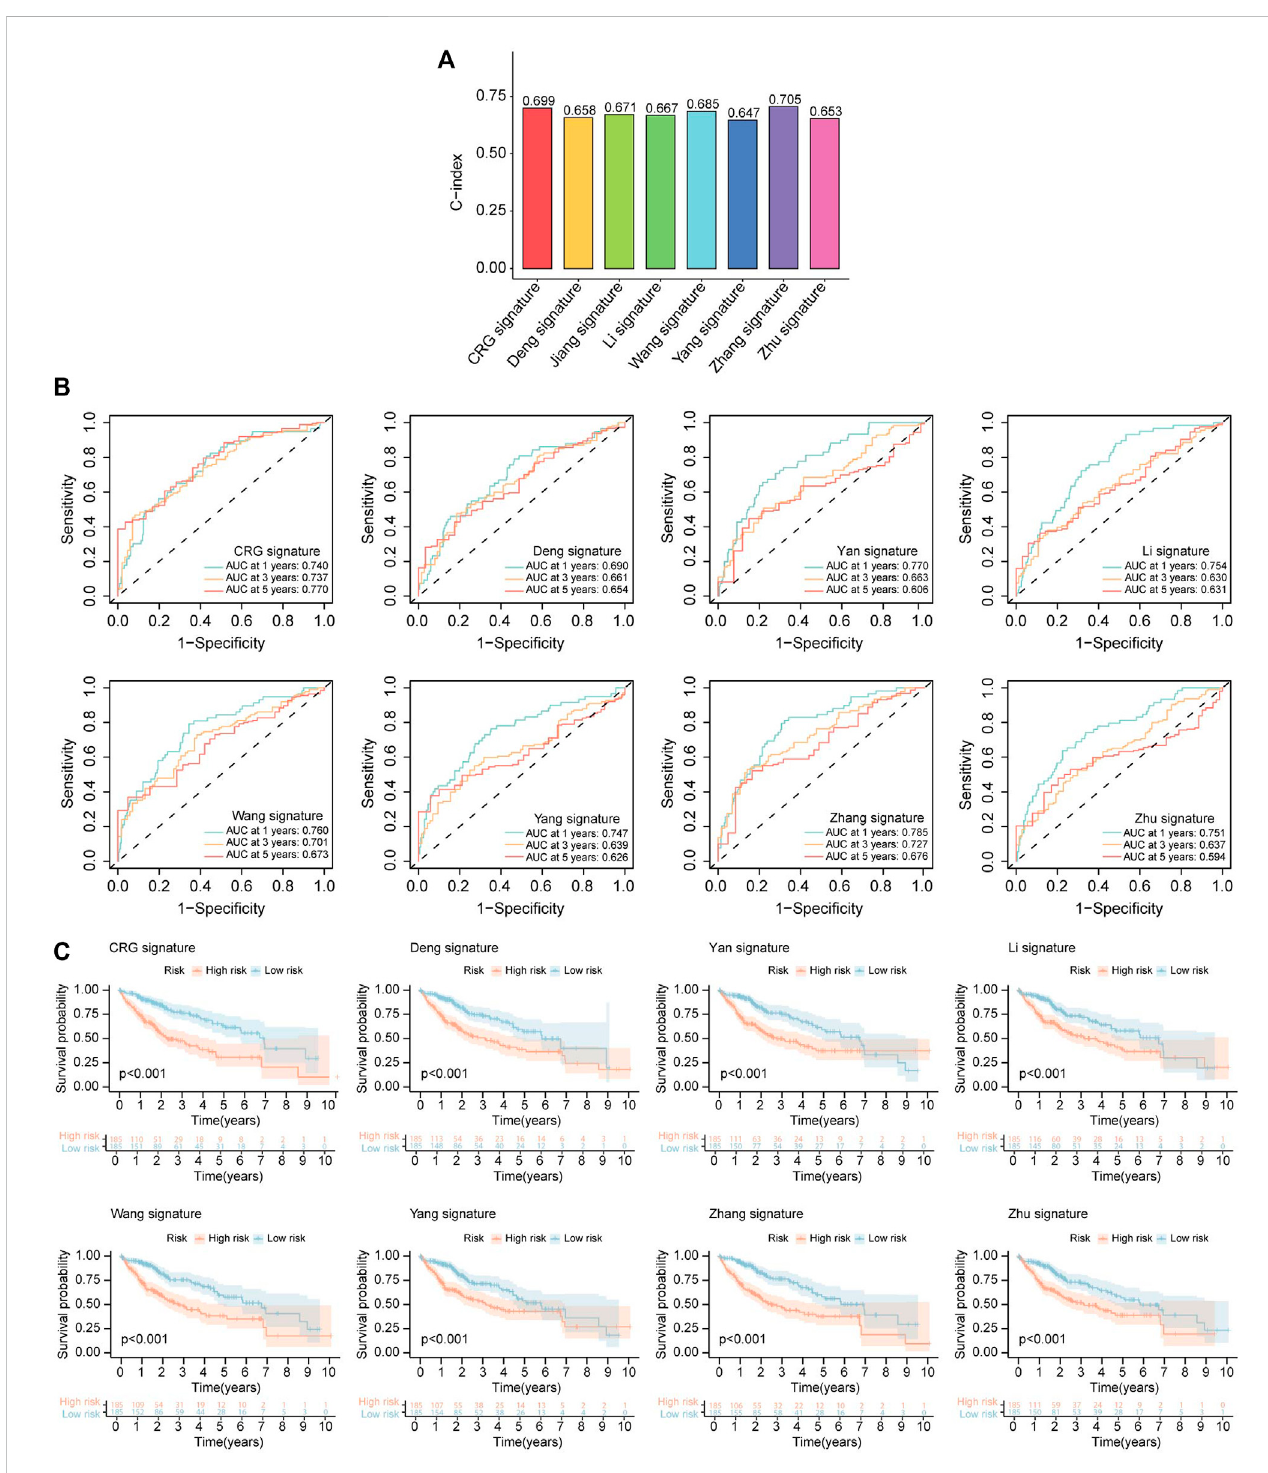
FIGURE 10 Comparison of CRLs prognostic signature and other models. (A) The C-index of our signature and other models. The C-index re fl ects the concordance of predicted results and actual situations. (B) ROC curves show the ef fi cacy of cuproptosis-related lncRNAs signature and that of other models in forecasting overall survival time of 1, 3, 5 years. (C) The K-M curves show HCC patients ’ survival time and survival status in CRLs signature and that of other